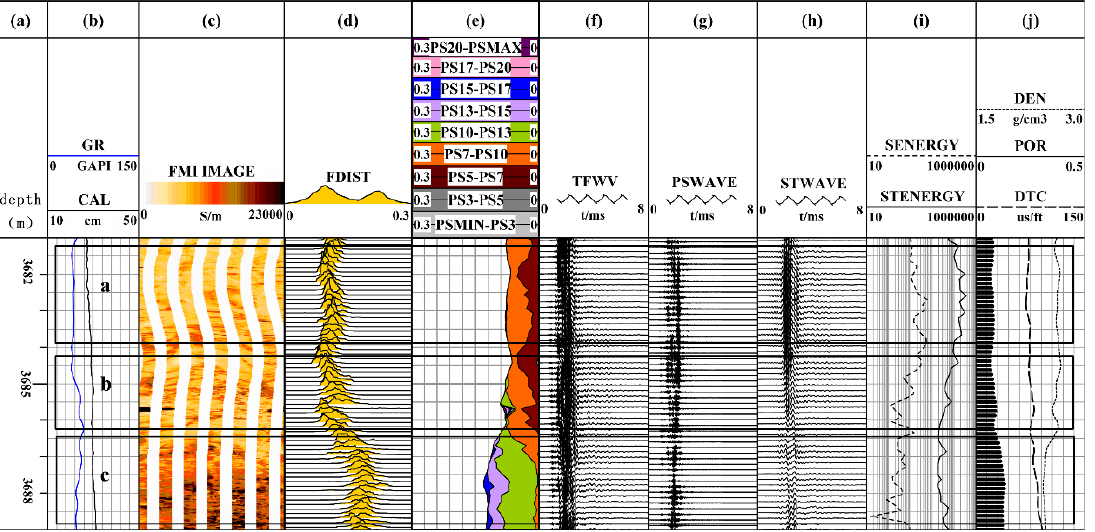
Figure 15. Comprehensive interpretation of logging data of cave formations with different development degrees. ( a ) Depth of the well; ( b ) GR is natural gamma and CAL is caliper; ( c ). FMI IMAGE represents electrical-imaging logging static image; ( d ) FDIST is the porosity-distribution spectrum; ( e ) PSMIN – PSMAX are the porosity of electrical imaging; ( f – h ) TFWV, PSWAVE and STWAVE are the waveforms of full-wave, P, S and ST waves, respectively; ( i ) SENERGY represents the energy of the S-wave. STENERGY is the energy of ST wave; ( j ) DEN is the density of the formation. POR is the porosity by conventional logging. DTC is the slowness of the P-wave.